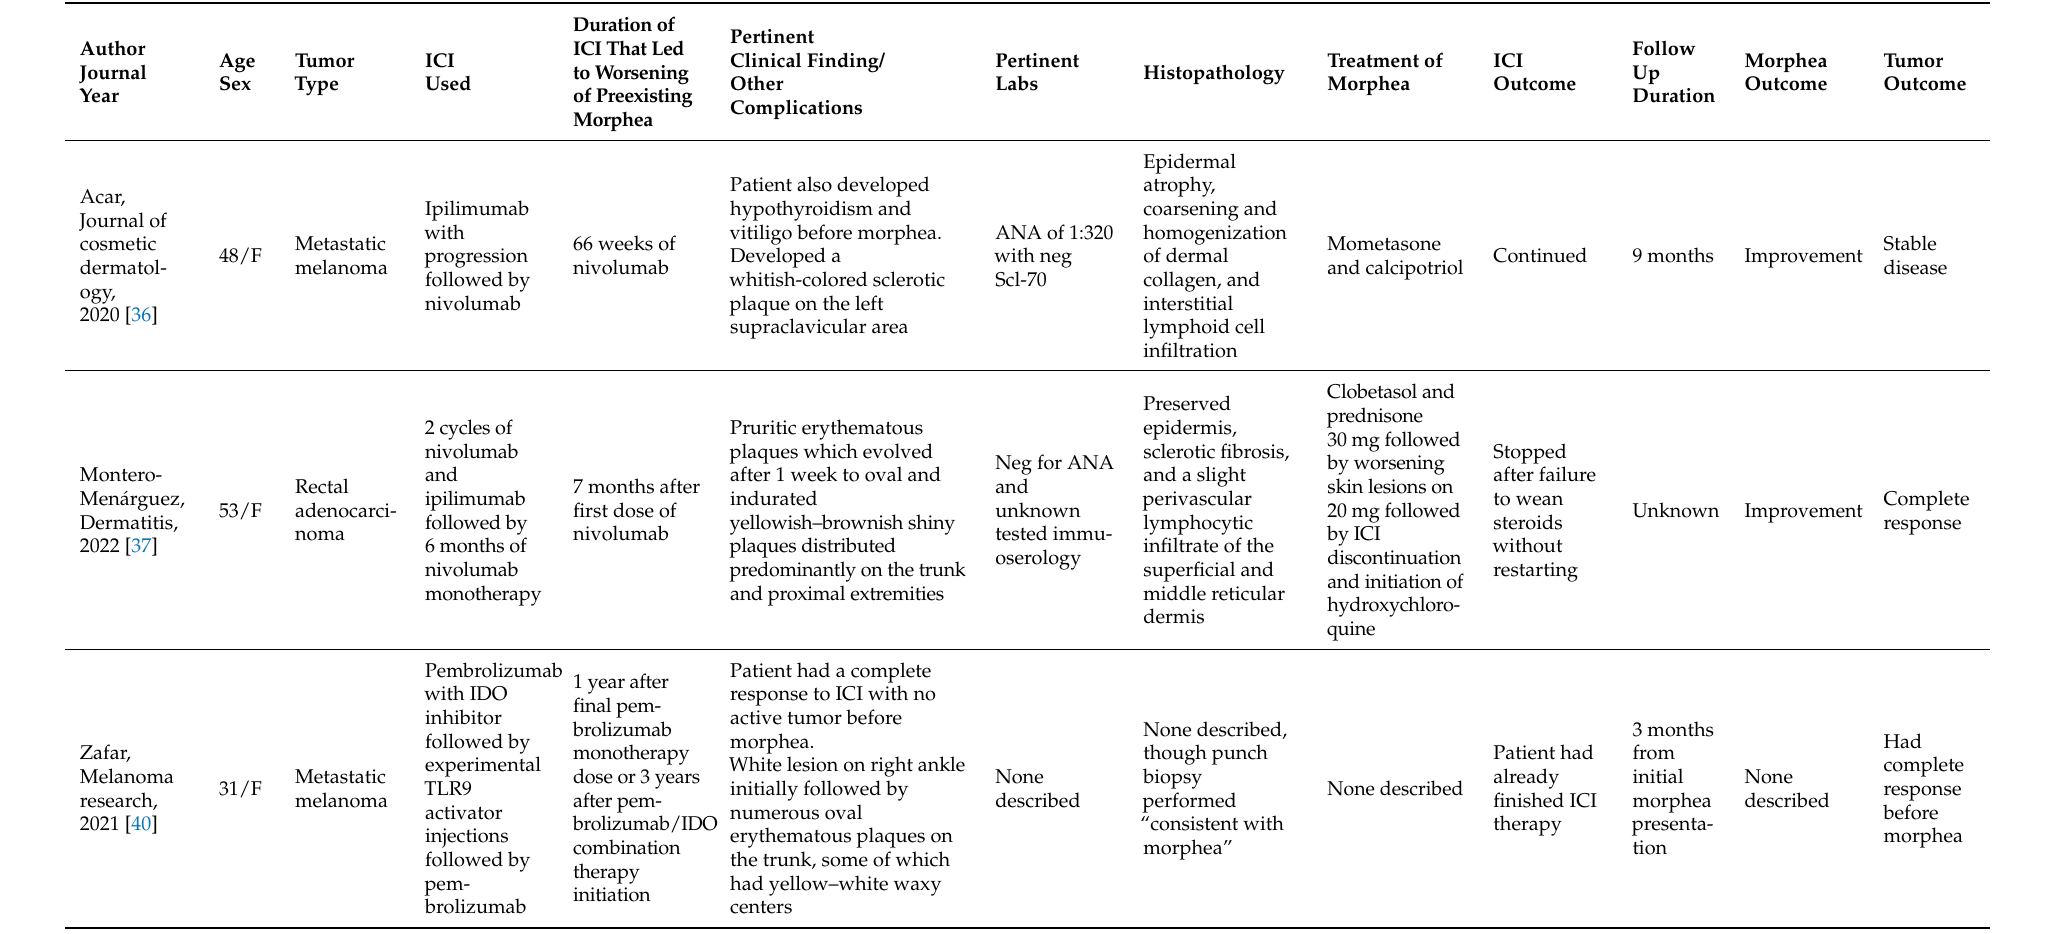
Table 3. Description of immune-checkpoint-inhibitor-induced morphea